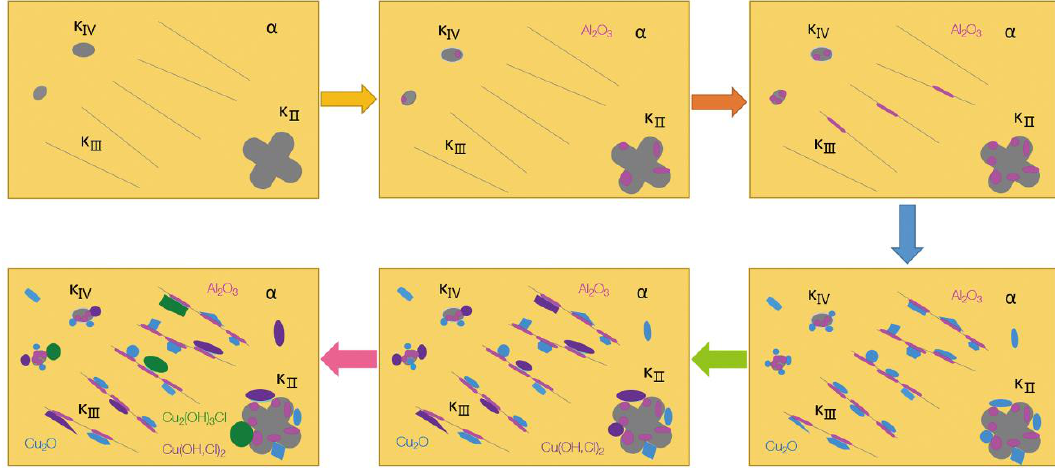
Figure 13. Process mechanism of corrosion behavior of S-Cast immersed in artificial seawater.